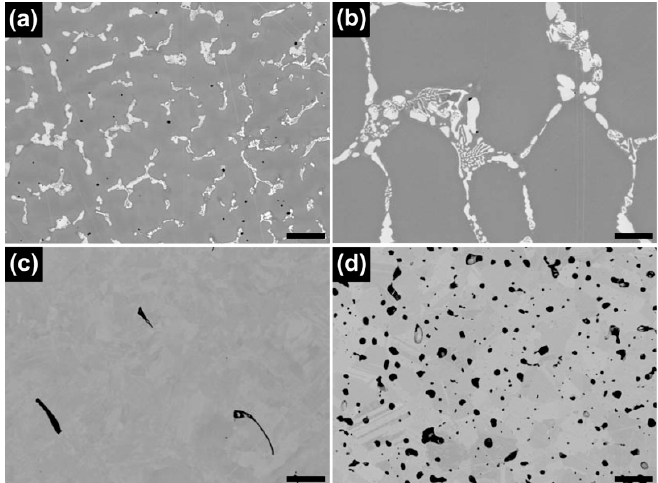
Figure 3. BSE images of the Co-Cr alloys tested. ( a ) CS; ( b ) ML; ( c ) SLM; and ( d ) ML/PS (500×, scale bar = 30 μ m). The secondary phases were observed in the CS and ML specimens, but such phases were absent in the SLM specimen.